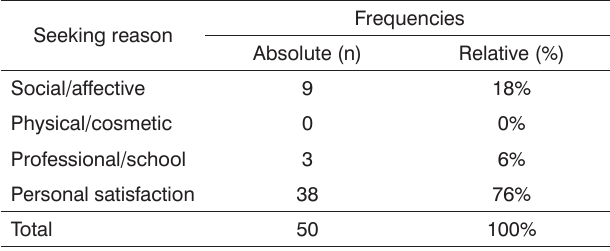
Table 2. Frequency distribution of the expectation-of-improvement- with-treatment variable, in the total sample.